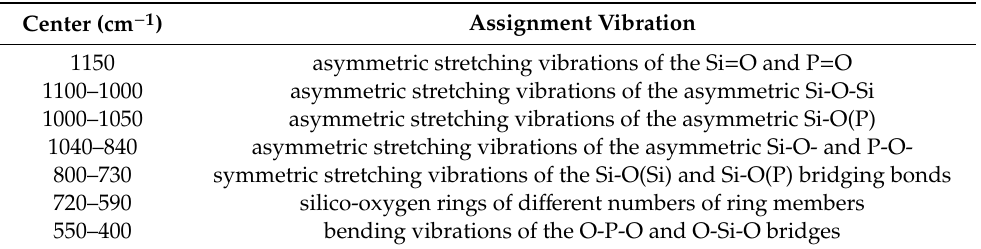
Table 3. Center assignment